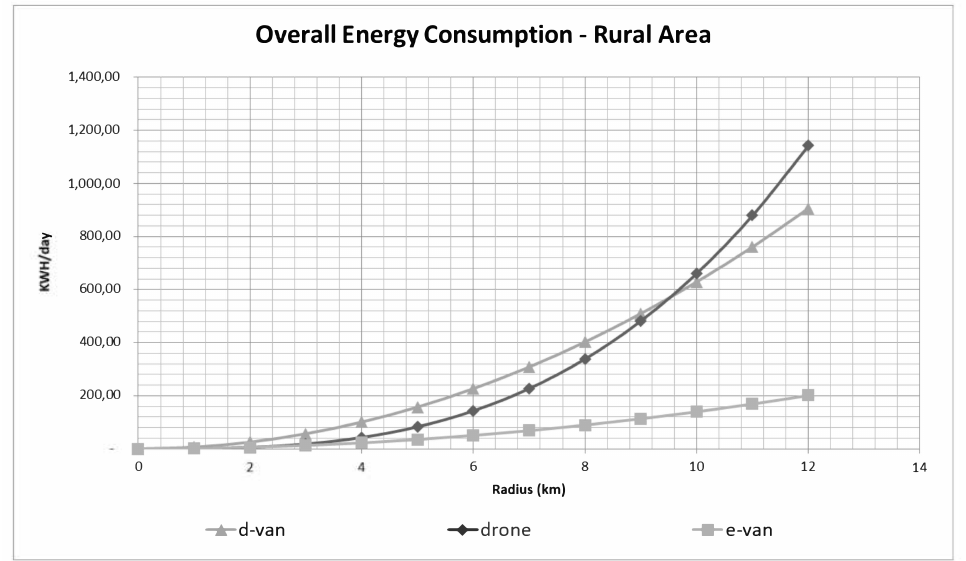
Figure 5. Energy consumption curves in Rural